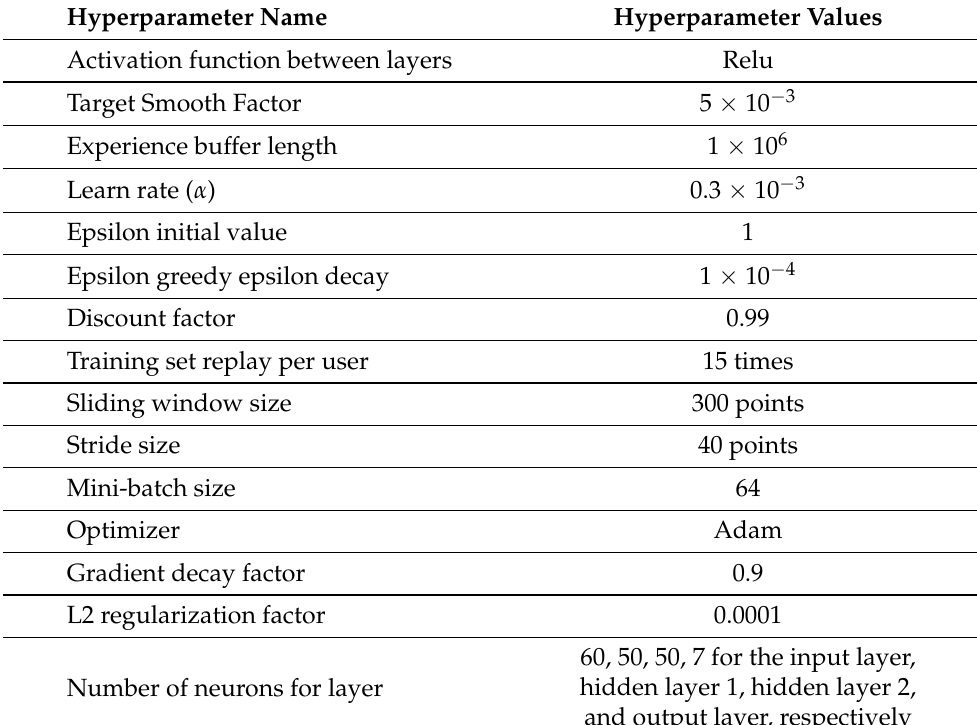
Table 2. Best hyperparameters found during validation